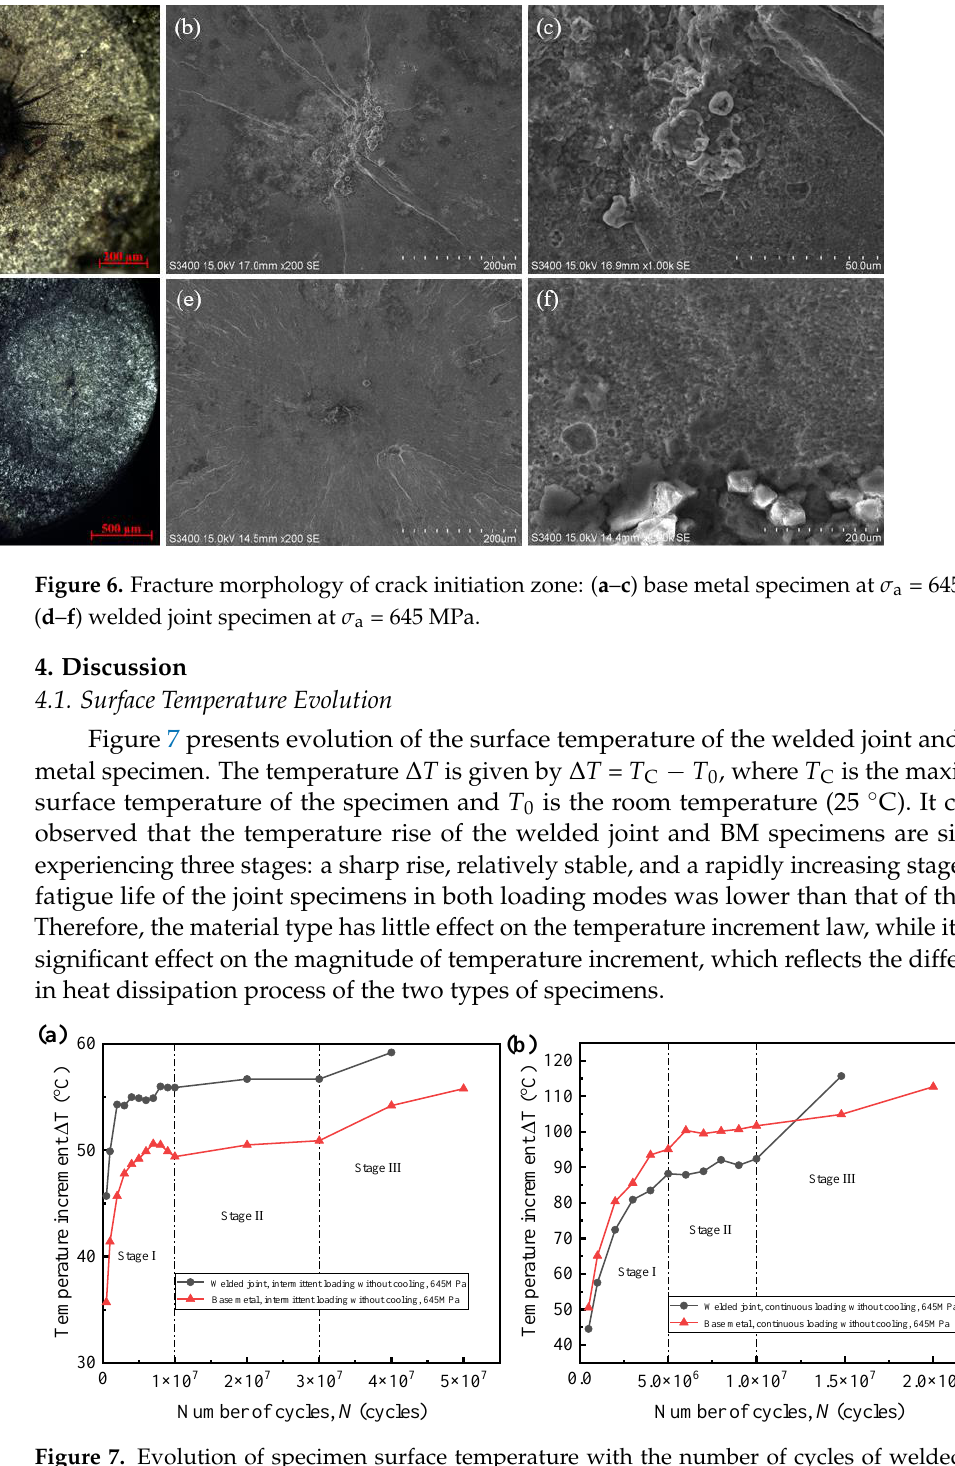
Figure 7. Evolution of specimen surface temperature with the number of cycles of welded joint and base metal specimens at σ a = 645 MPa: ( a ) intermittent loading without cooling, ( b ) continuous loading without